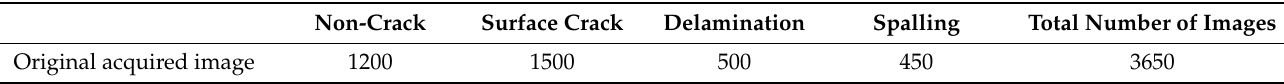
Table 1. Breakdown of the dataset used in this study.